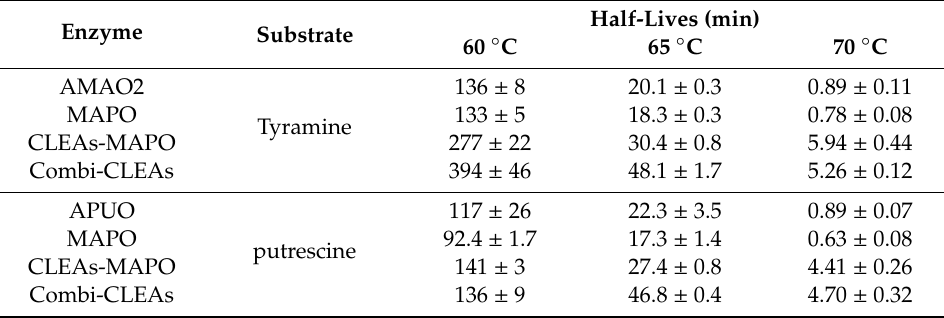
Table 1. Half-lives of free and CLEAs amine oxidases at di ff erent temperatures. Enzyme